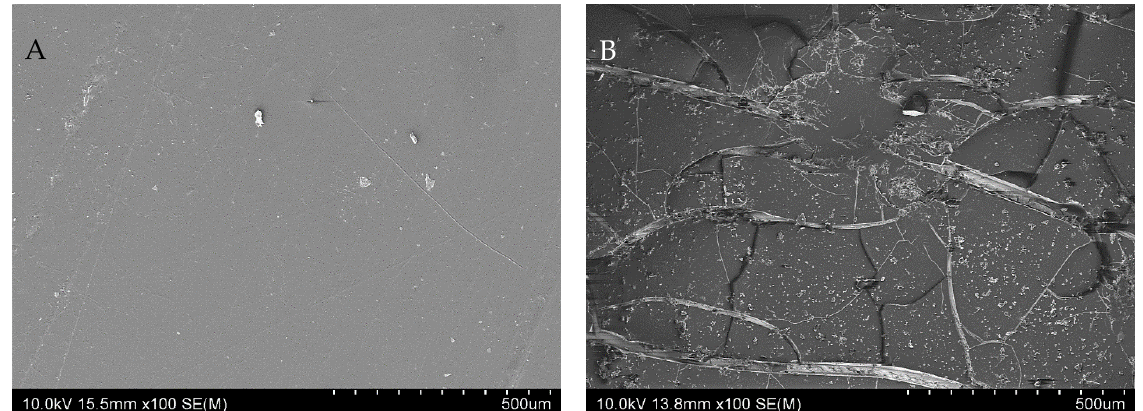
Figure 3. SEM images of ( A ) — unaged iPP and ( B ) — iPP after UV exposure for 1000 h.